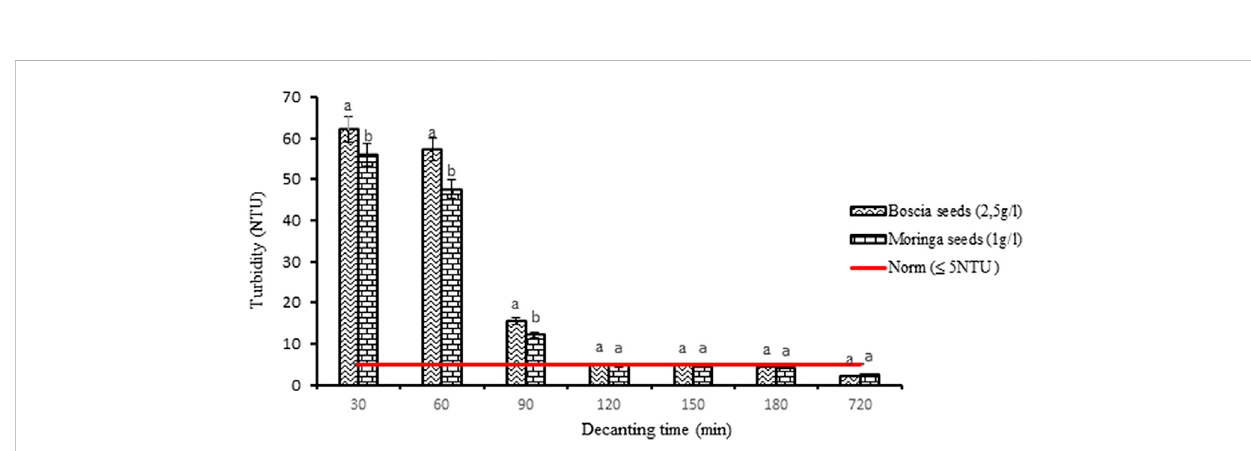
FIGURE 7 Measurement of turbidity of water samples treated with Moringa oleifera (Mo) and Boscia senegalensis (Bs), at different decanting time.